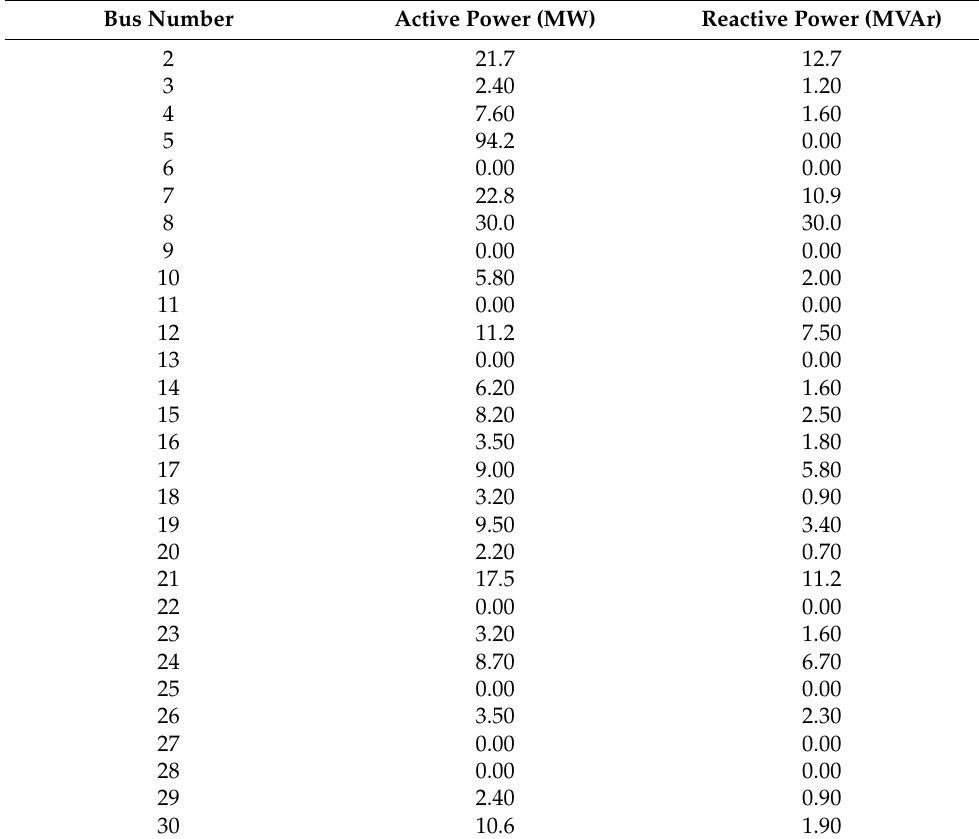
Table A5. Loads data.